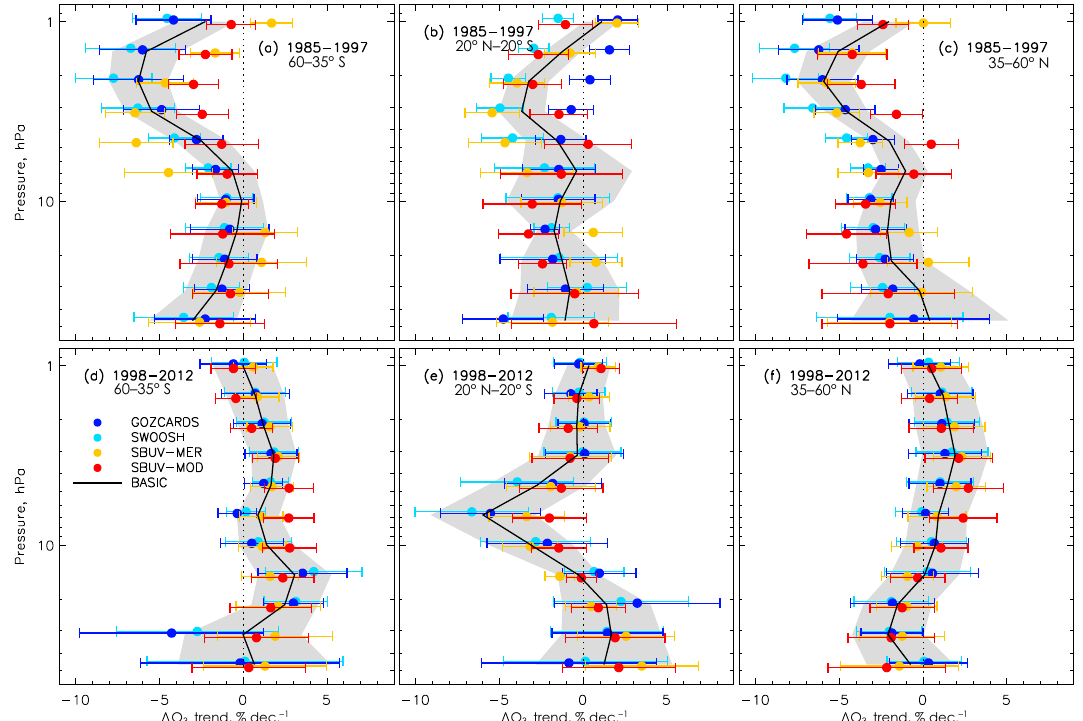
Figure A11. The decadal trend in ozone from multiple linear regression (MLR) between 1985 and 1997 (a–c) and 1998 and 2012 (d–f) , over 60–35 ◦ S (a, d) , 20 ◦ S–20 ◦ N (b, e) , and 35–60 ◦ N (c, f) . GOZCARDS, SWOOSH, SBUV-MER, and SBUV-MOD are shown with 95% credible intervals; the BASIC composite is shown in black with shading representing 95% credible